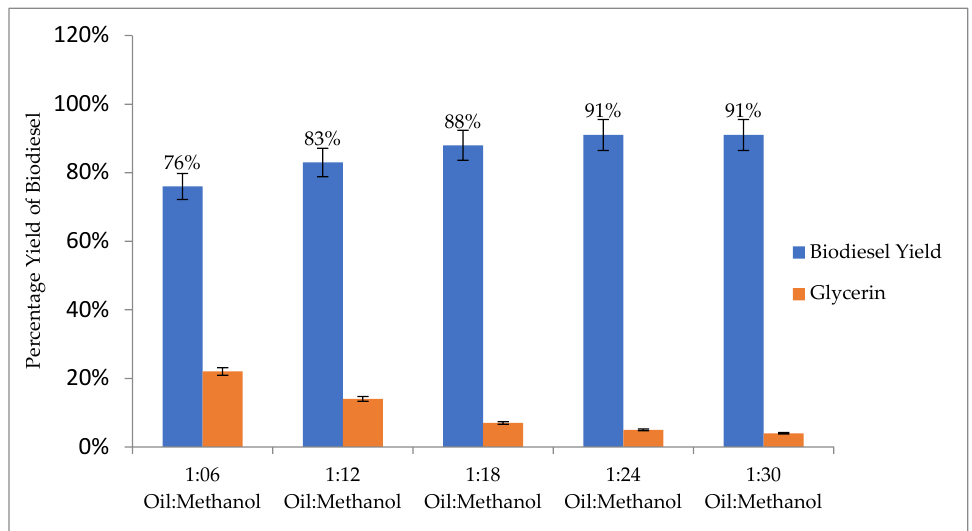
Figure 3. Oil-to-methanol ratio has a positive effect on biodiesel yield and a negative effect on glycerin formation.